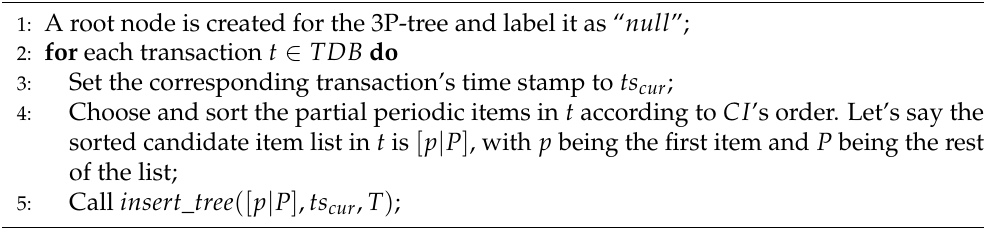
Figure 3. Construction of the 3P-tree: ( a ) the tree after reading the first transaction; ( b ) the tree after reading the second transaction; ( c ) the tree after reading the third transaction; ( d ) the tree after reading the fourth transaction; ( e ) the tree after reading the fifth transaction; ( f ) the tree after reading the sixth transaction; ( g ) the final 3P-tree that was generated after reading the entire database. Algorithm 2 3P-tree: TDB , 3P-list